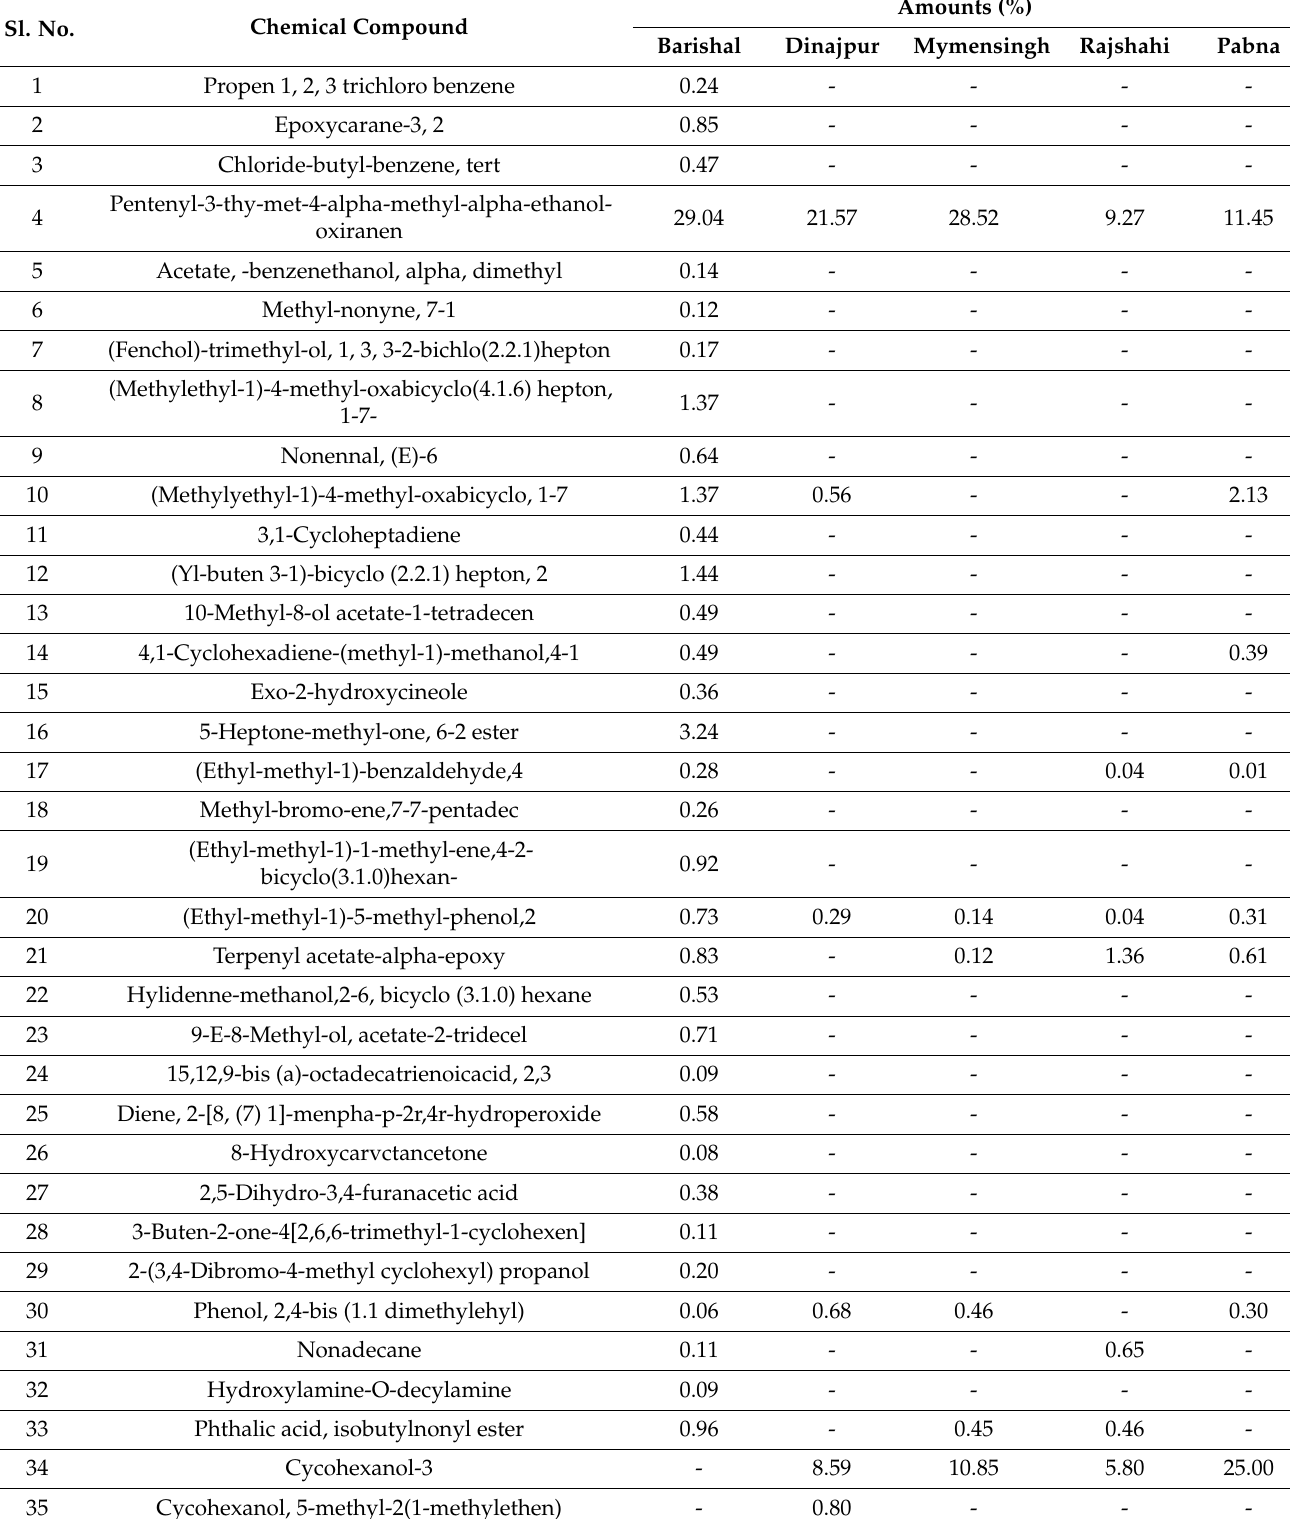
Table 2. Chemical compounds obtained from hog plum samples by GC-MS (Retention time: 5.52–22.34 min). Sl.